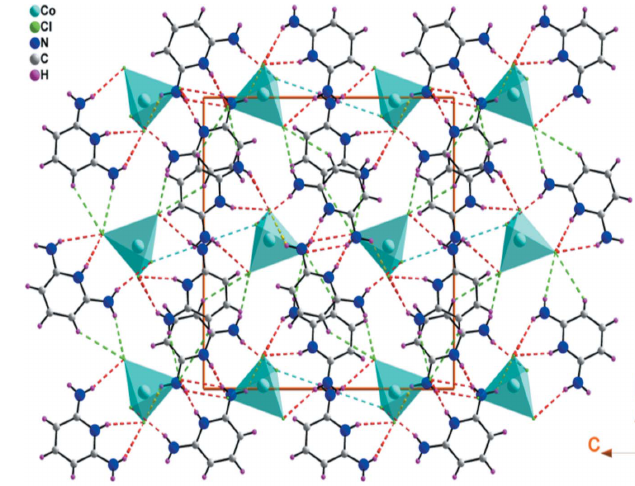
Figure 2 The interanionic Cl (cid:2)(cid:2)(cid:2) Cl contact in the tetrachlorocobaltate anion of (I) along the a and c axis.